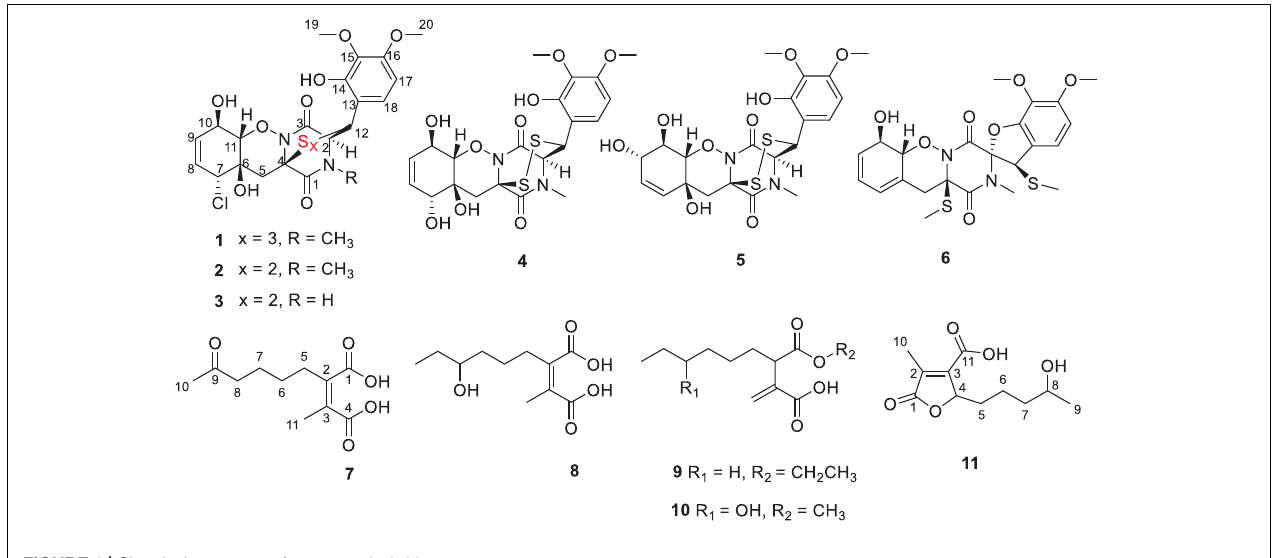
FIGURE 1 | Chemical structures of compounds 1 - 11 .